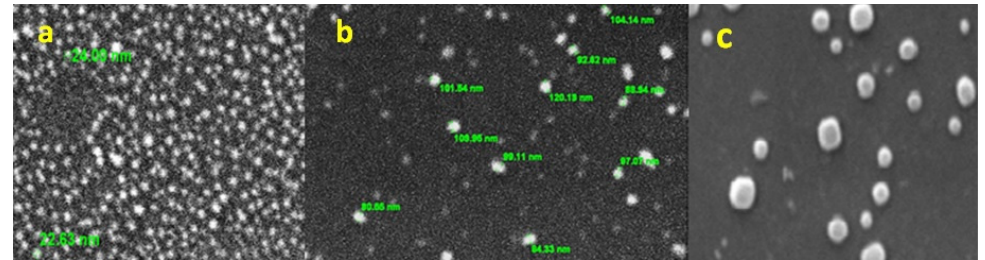
Figure 3. SEM micrographs of ( a ) AuNPs, ( b ) AuNPs (2 mM), and ( c ) CIP-AuNPs (2.5 mM). Besides, EDX analysis was carried out for elemental mapping of CIP-AuNPs (2.5 mM) (Supplementary Materials Figure S1, Section